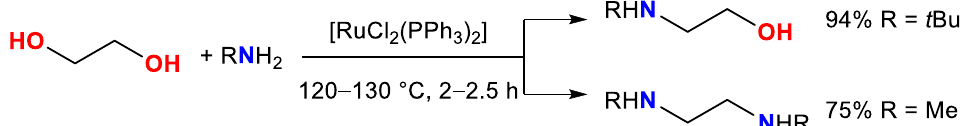
Scheme 26. Effect of the steric parameter on selectivity. Table 4. Typical catalysts used for diol Table 4. Typical catalysts used for diol amination.